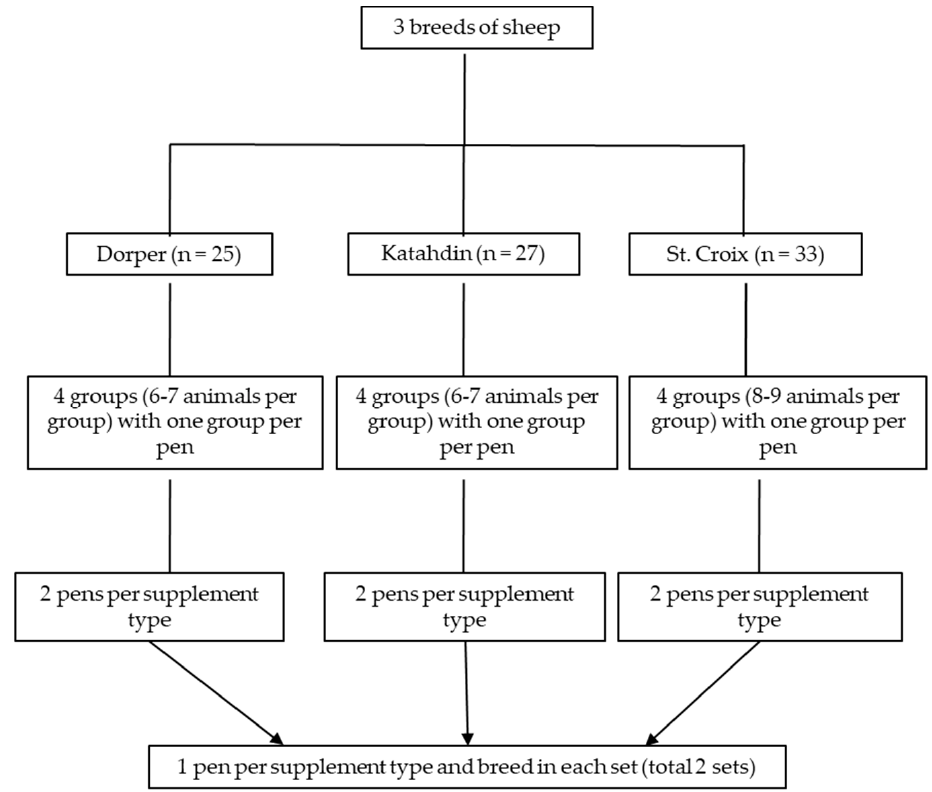
Figure 1. Schematic presentation of the experimental design.